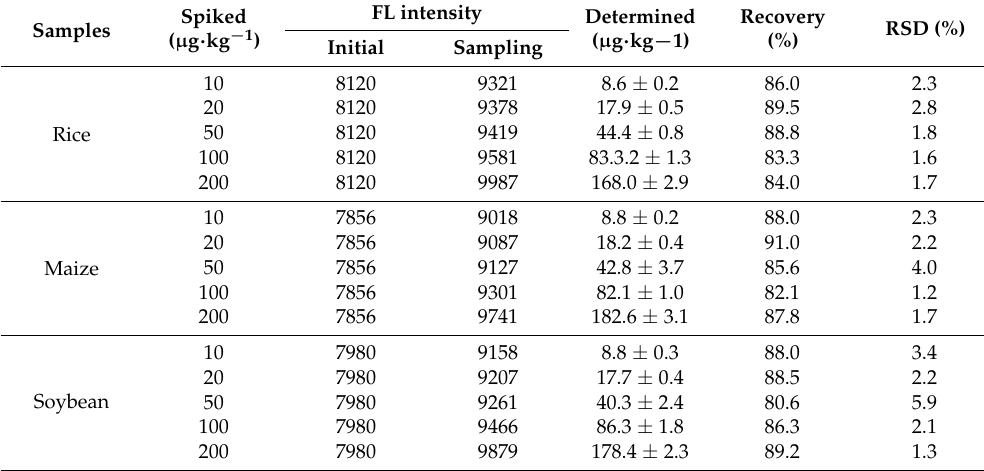
Table 4. Application of the developed MIP probe for the determination of ST in cereal samples (Mean ±